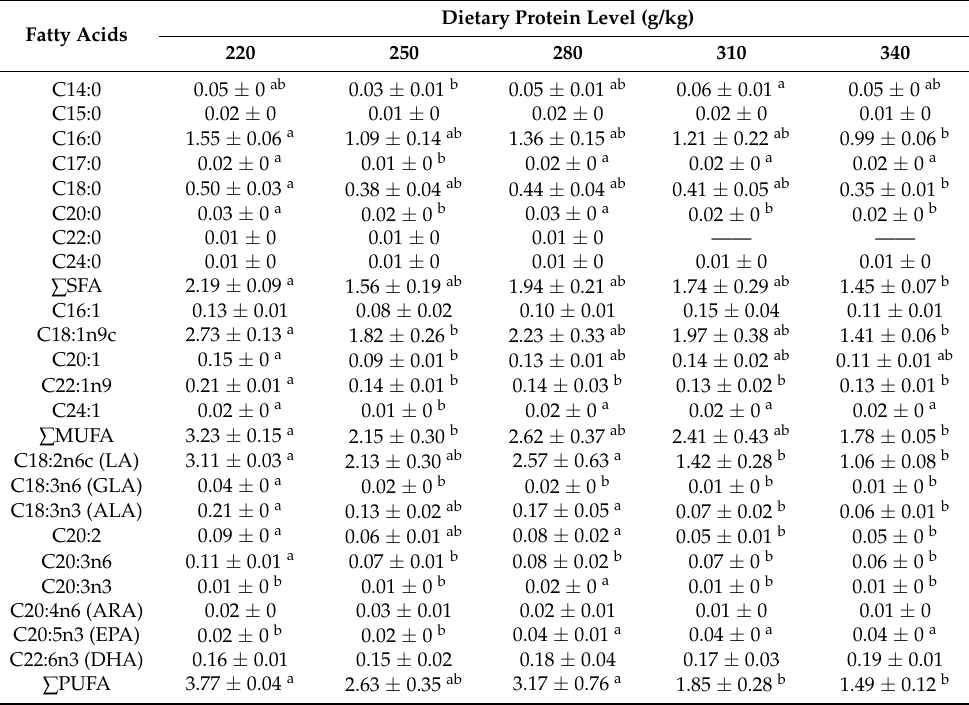
Table 5. Effects of different dietary protein levels on the fatty acids and evaluation of Cyprinus carpio haematopterus (g/100g, dry